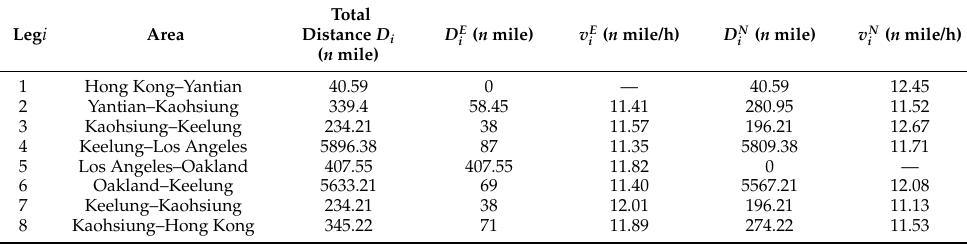
Table 9. Results of minimum CO 2 emissions of speed.